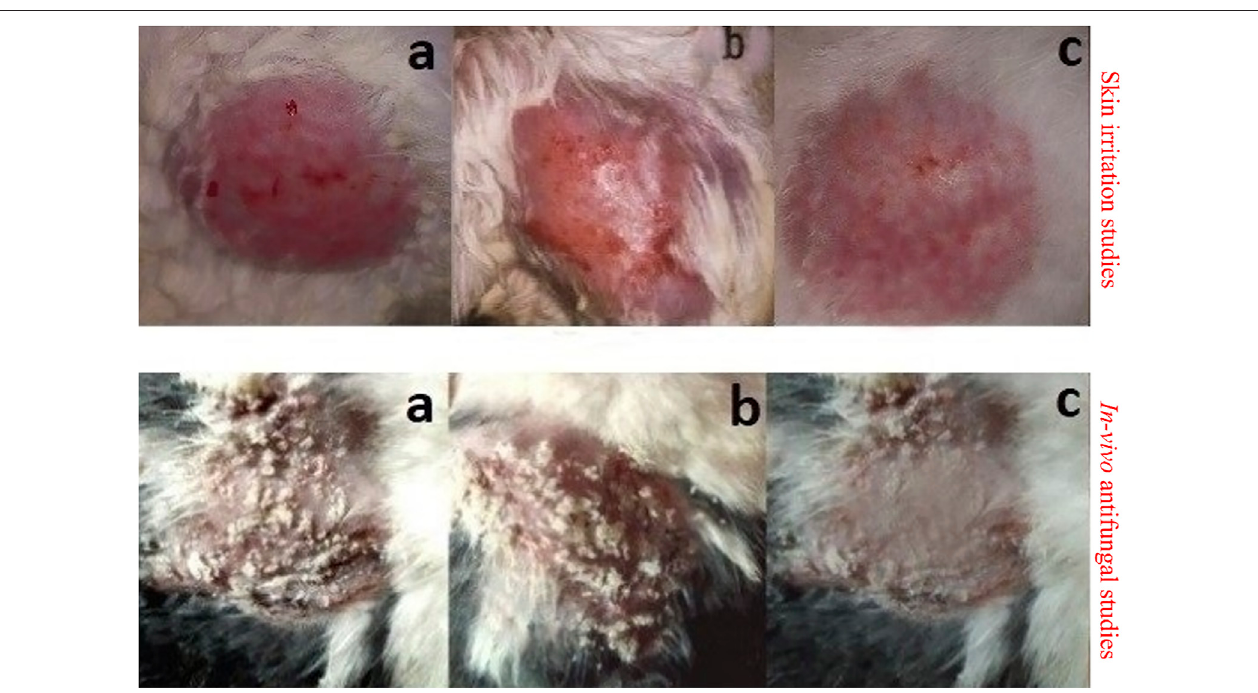
FIGURE 6 | Skin irritation studies and in vivo antifungal studies in control group (A) , group treated with pure EN-TA suspension (B) , and group treated with EN-TA loaded MSNs (C) .